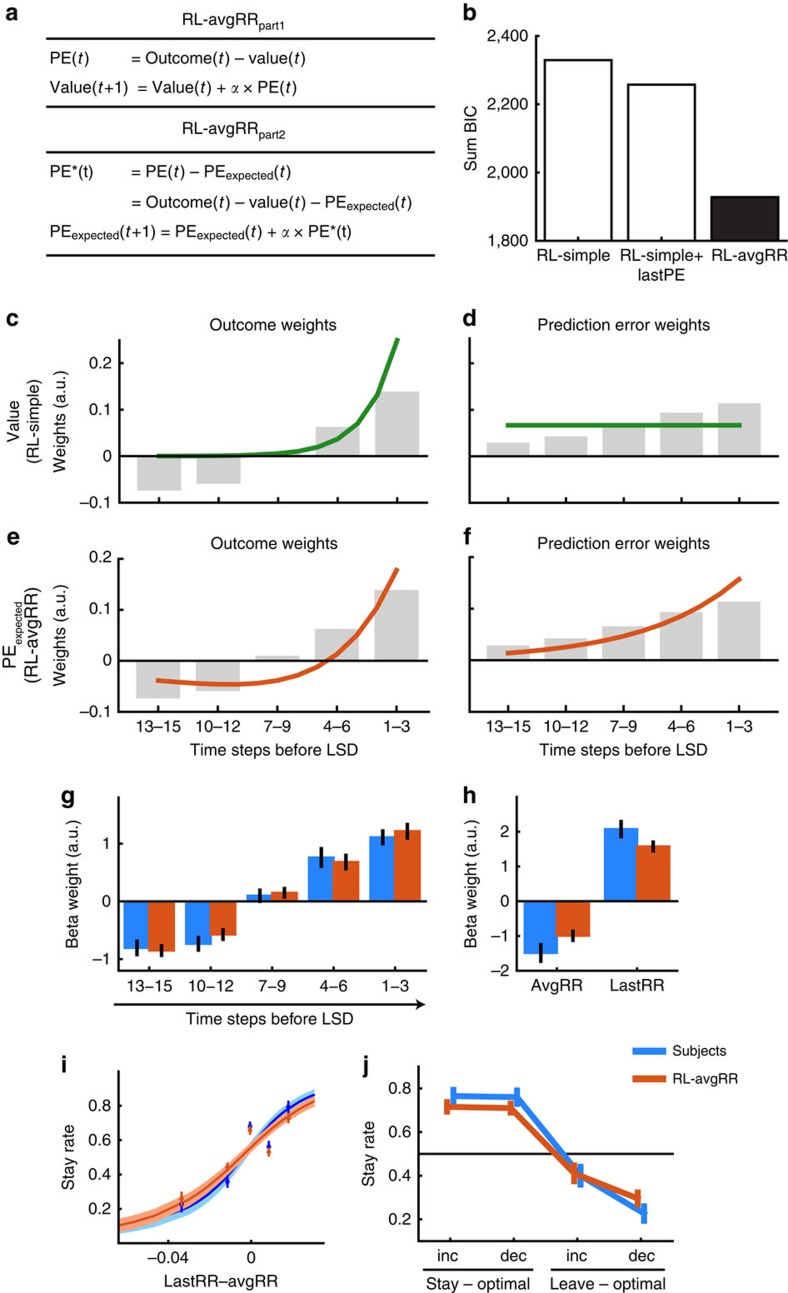
RL-avgRR explains reward rate trend-guided choices.(a) Equations used in RL-avgRR. (b) Summed Bayesian information criterion (BIC) scores for RL-avgRR were lower than RL-simple and RL-simple+lastPE, indicating better model fit. (c–f) Comparison of past outcome and PE weights used by a standard value estimate and PEexpected at the time of choice (same x-axis in all plots). Grey bars indicate the weights of influence that past outcomes (c,e, same data) and past PEs (d,f, same data) had on subjects' decision to stay in a patch. The lines indicate the amount of influence past events had on the calculation of a simple value estimate (from RL-simple; green line) and PEexpected (from RL-avgRR; orange line). Note that the empirically determined weights correspond qualitatively to the weights used by RL-avgRR, but not to RL-simple. While simple value estimates are a recency-weighted sum of past outcomes (c), expected PEs are highest when encountering high rewards after initially poor outcomes (negative than positive weighting, e). The same information as in c,e can be presented as a function of PEs for RL-simple (d) and RL-avgRR (f). Again, the influence of past PEs on subjects' choices are qualitatively similar to the way PEexpected is calculated from past PEs. (g–j) Analyses from Fig. 2 were repeated for RL-avgRR. Unlike RL-simple (Fig. 2), RL-avgRR made choice predictions (orange) that were similar to subjects' actual choices (blue). Note, in particular, how the weights in 3 g mimic the theoretical weights shown in e and that RL-avgRR is able to represent past rewards negatively. See Fig. 2 for legends.